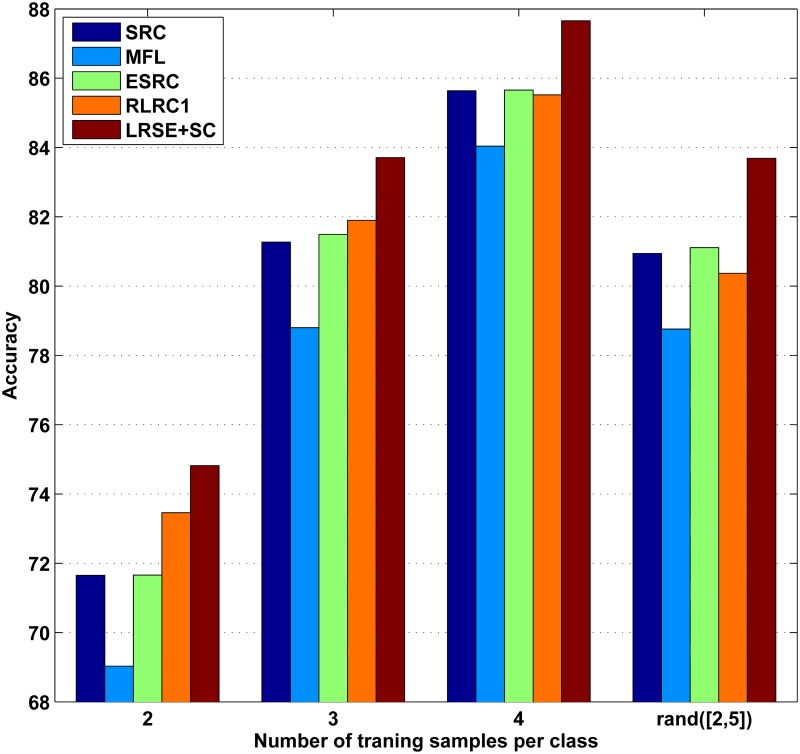
Recognition rates on AR database with different number of training samples per class.In this experiment, for each subject, 14 images with only illumination and expression changes are selected. rand([2, 5]) means the number of training images belonging to the ith class is a random number between 2 and 5.